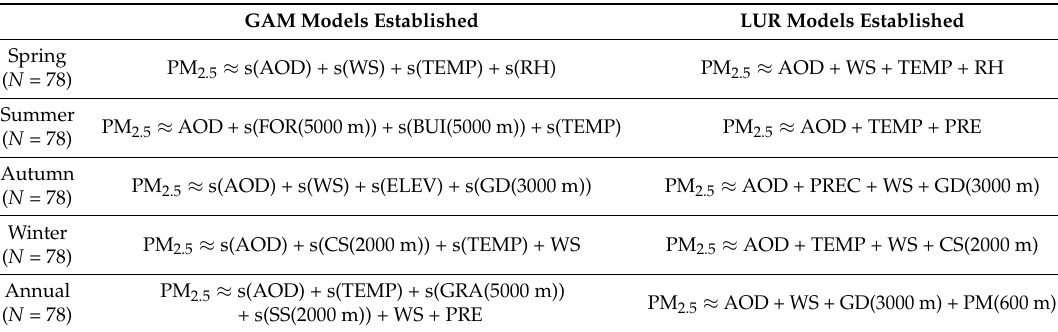
Figure 2. Scatterplots of GAM model fitting and validating results. The dashed line is the 1:1 line as a reference. ( a – e ) are GAM model fitting results of spring, summer, autumn, winter, and annual, respectively; ( f – j ) are 10-fold validating results for GAM model of spring, summer, autumn, winter, and annual, respectively. Table 2. Predictor variables for GAM and LUR